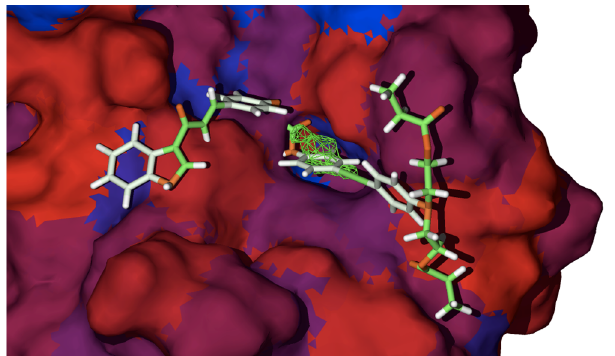
Figure 10. Hydrophobic interactions between KLK5 protease and 15 . Blue and red surfaces depict a hydrophobic and hydrophilic behavior, respectively.